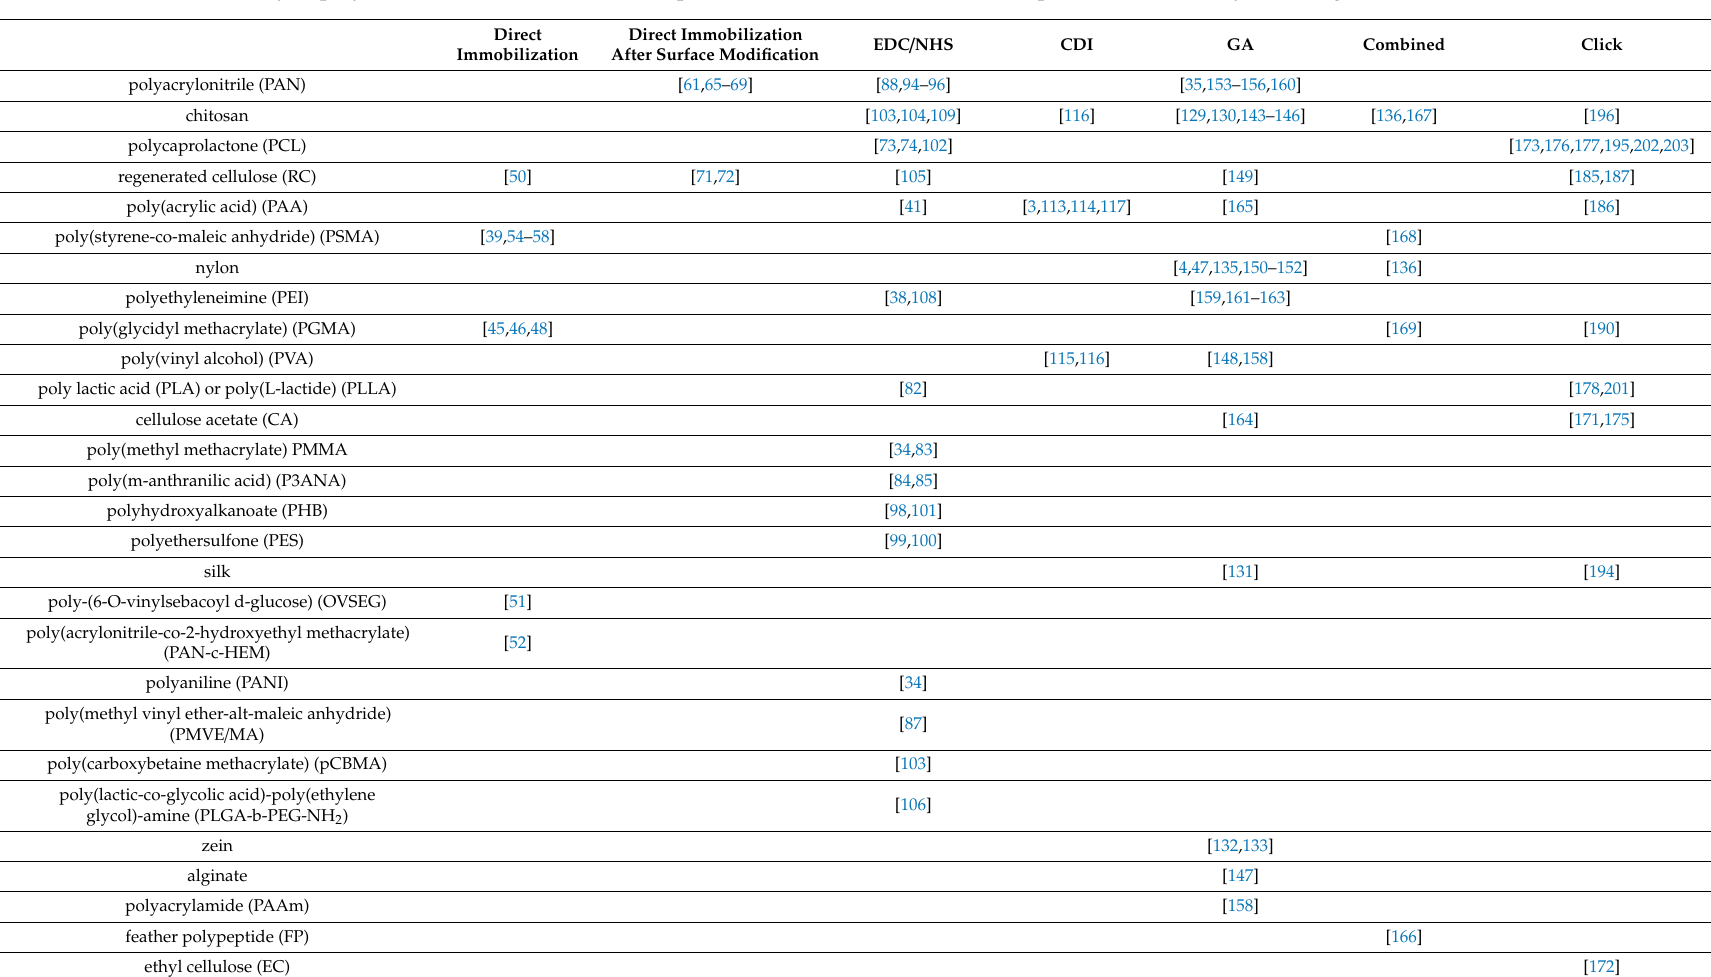
Table 1. Summary of polymers (left column) used in the specified immobilization methods (top row) for covalently attaching biomolecules to